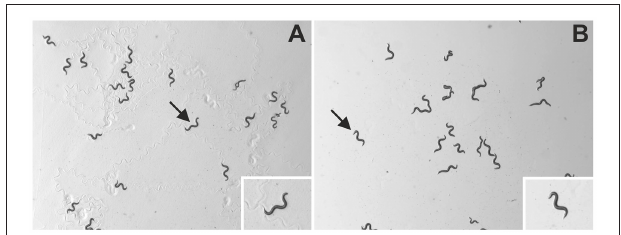
FIGURE 1 | Representative images of C. elegans as analyzed in the present study. The panels show unprocessed frames of videos of wild type (N2) C. elegans on NGM-agar plates with an E. coli lawn (A) or with no lawn (B) . The insets show individual worms (indicated by arrows) at higher magnification. The slightly uneven illumination of the panels stems from the fact that in the experimental setup of the present study, the field-of-view was placed offset from the middle of the agar plates. However, this had no impact on unequivocal identification and tracking of the worms on the plates (evaluation data not shown).